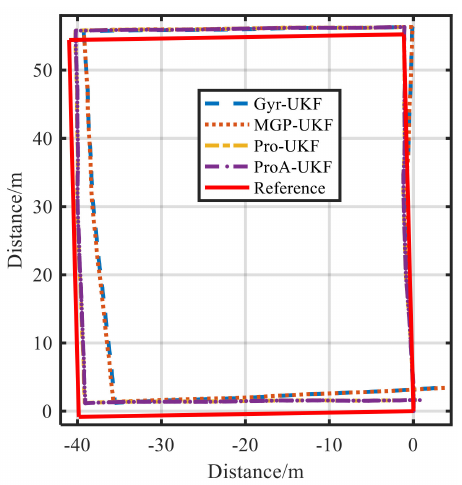
Figure 7. Trajectories of di ff erent heading estimations for HV9.